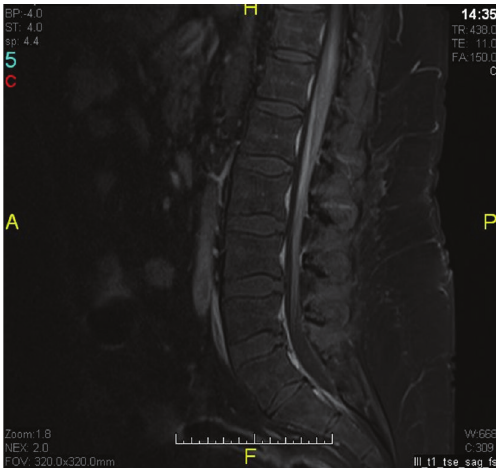
Figure 2: Focal enhancement within posterolateral columns corre- sponding to the area of high signal changes on